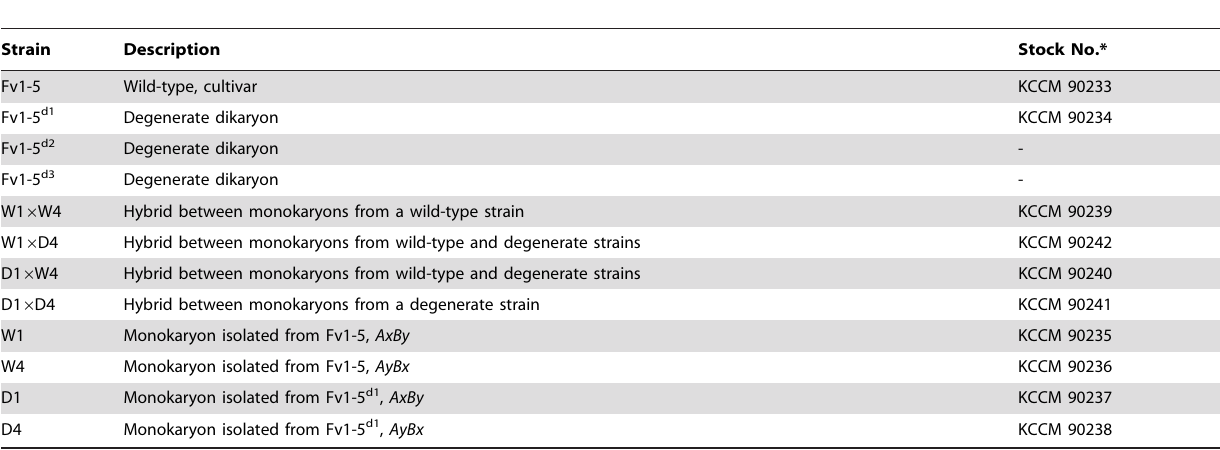
Table 1. List of the F. velutipes strains used in this study.